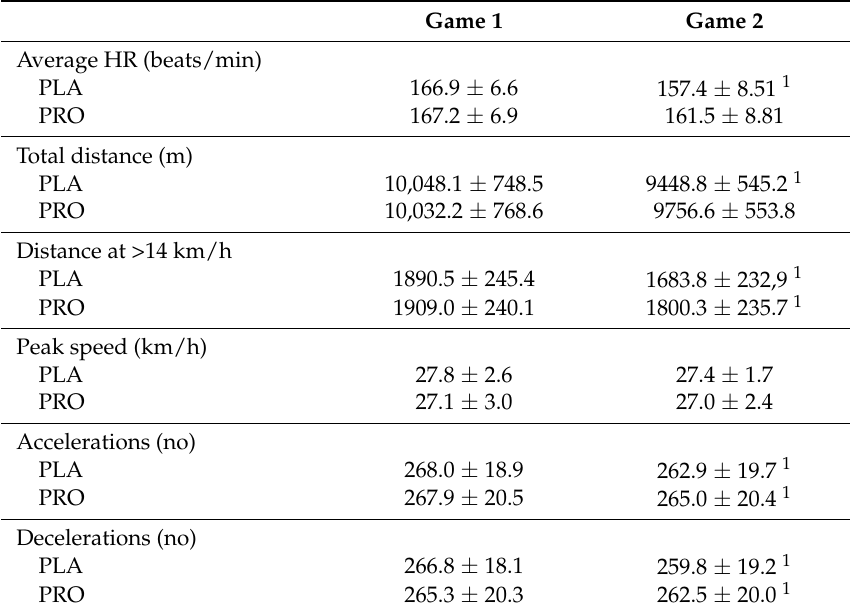
Table 3. Changes in game field activity in response to protein and placebo